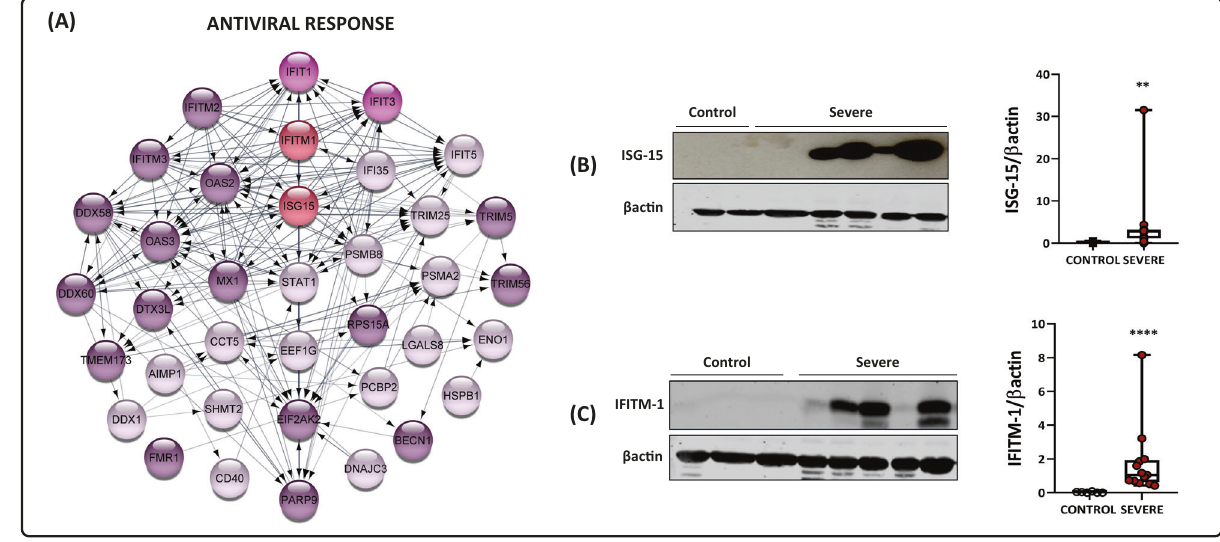
Fig. 4 Antiviral response in the platelet proteome. A PPI is related to the response through type-I interferon. Each color represents a different EP/DEP classi fi cation: purple EPs represent PPIs described in the COVID-19 group. The EPs IFIT1 and 3, EPs from the COVID-19 group, and a DEP exclusive to the survivor group subset are represented in pink. The DEPs from the COVID-19 group are displayed in light pink. Last, the validated proteins ISG-15 and IFITM-1, both EPs from the COVID-19 group, are represented in red. All DEPs were shown to be upregulated. B Western blot analysis of ISG-15 and β -actin in platelets isolated from three healthy volunteers (controls) and nine patients with severe COVID-19. C Western blot analysis of IFITM-1 and β -actin in platelets isolated from three controls and nine patients with severe COVID-19. The densitometric analyses of each band are represented in a graph. The boxes indicate the median and interquartile ranges, and whiskers indicate minimal and maximal values in each group. * p < 0.05 between controls and severe COVID-19 patients (unpaired t